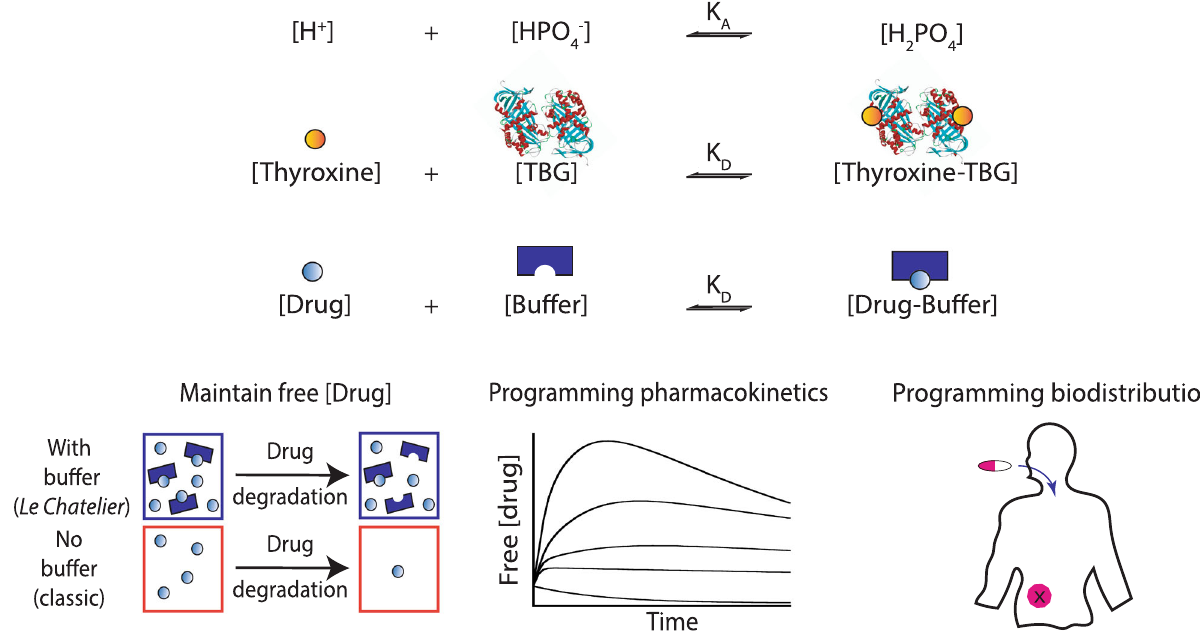
Fig. 1 | Drug delivery systems (DDS) based on natural molecular buffers. Top: Nature employs molecular buffers like HPO 4 - and TBG to maintain a constant concentration of active biomolecules using Le Chatelier ’ s principle for H + and thyroxine, respectively. Bottom left: Similarly, we can engineer self-regulated molecular buffers to sequester a large reservoir of inactive drugs and to maintain